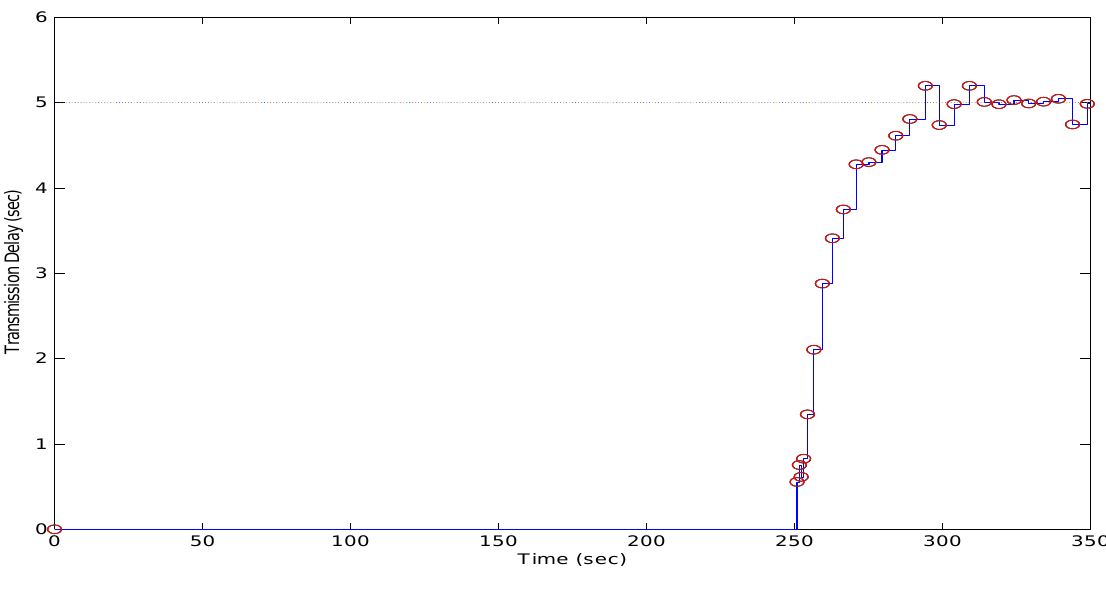
Figure 11 . Measured Time Delay for transmitting an image frame over experimental time (Initial values R = 0 : 1 , T d = 5 s, and (cid:22) = 0 : 01